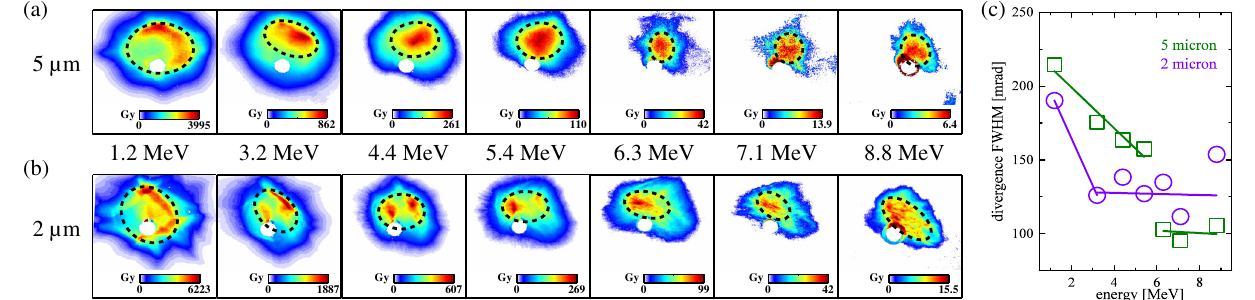
FIG. 3. Processed radiochromic film data: proton beam profiles originating from 5 micron (a) and 2 micron (b) thick Ti targets. The energy of the fully stopped protons is given in MeV for each film layer. The deposited dose (Gy) in each layer is given by the color scale of the individual image. The divergence was derived as the FWHM of a fitted Gaussian profile to the measured dose distribution and shown for 5 micron (green squares) and 2 micron (purple circles) for each layer, i.e., proton energy in (c). The solid lines are piecewise linear fits of the data. The visible holes in the RCF film do not correspond to the target normal